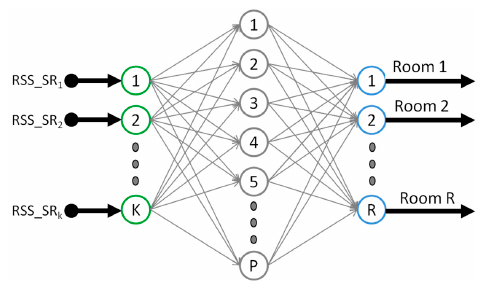
Figure 5. Multilayer perceptron: Proposed architecture.